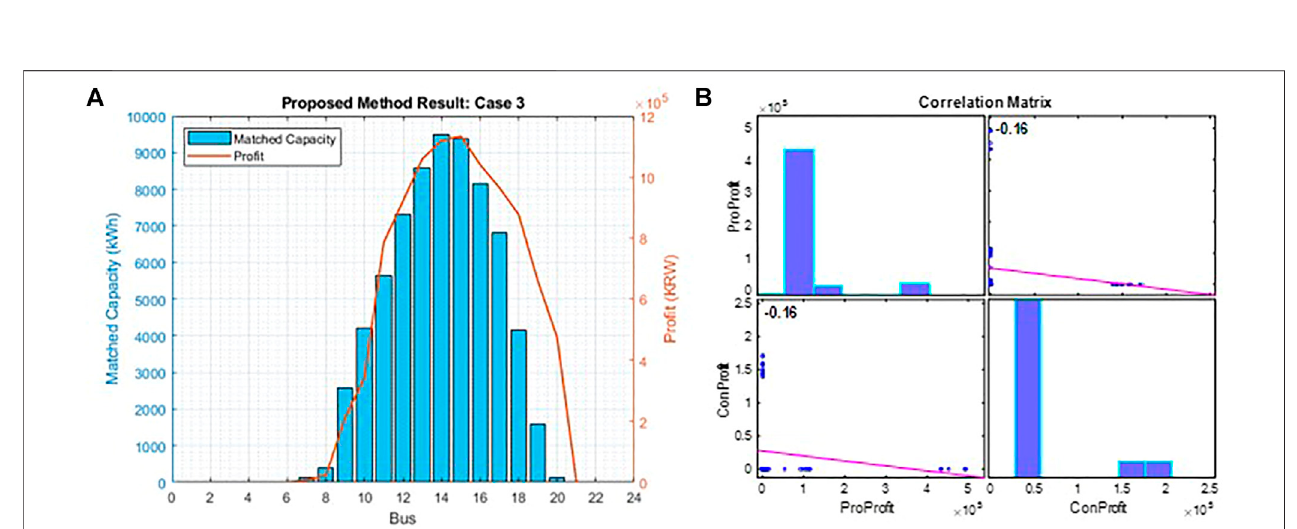
FIGURE 12 | (A) Matched capacity results and (B) correlation coef fi cient of the proposed method for Case 3.